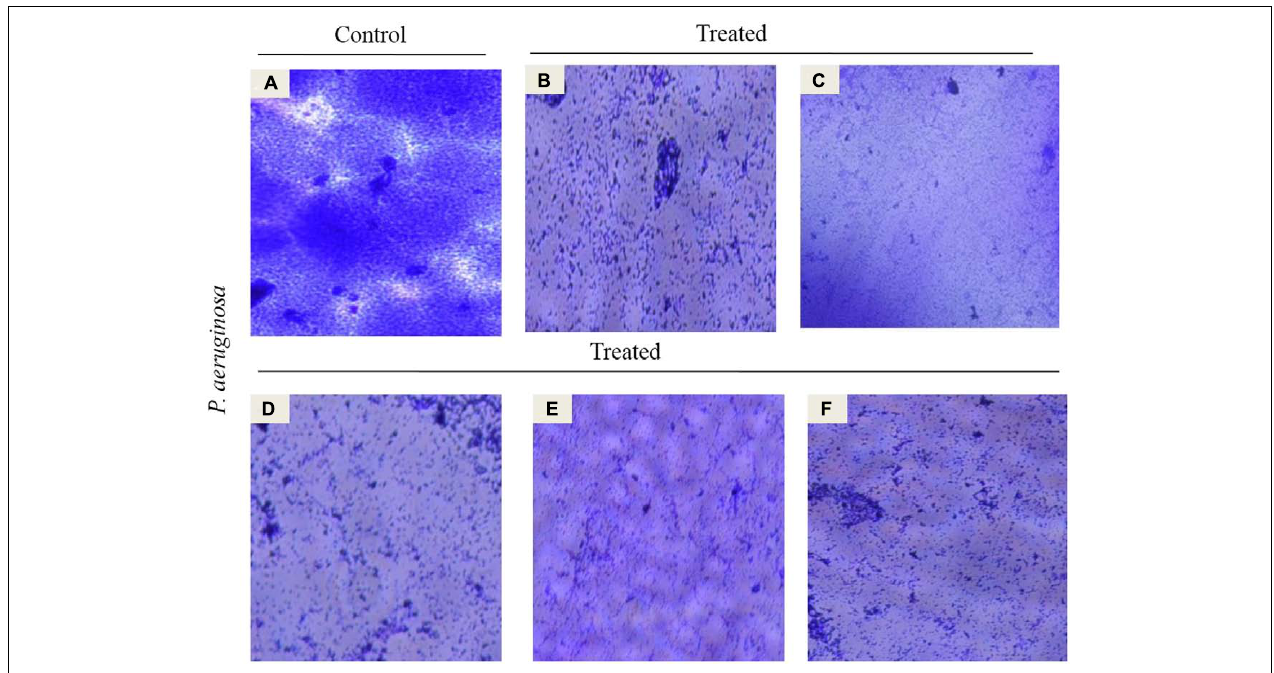
FIGURE 4 | Light microscopic images at 40 × demonstrate the inhibition of P. aeruginosa young biofilm. (A) Control, (B) EO treated, (C) DNaseI treated, (D) MBD treated, (E) EO + DNaseI, (F) EO + MBD.